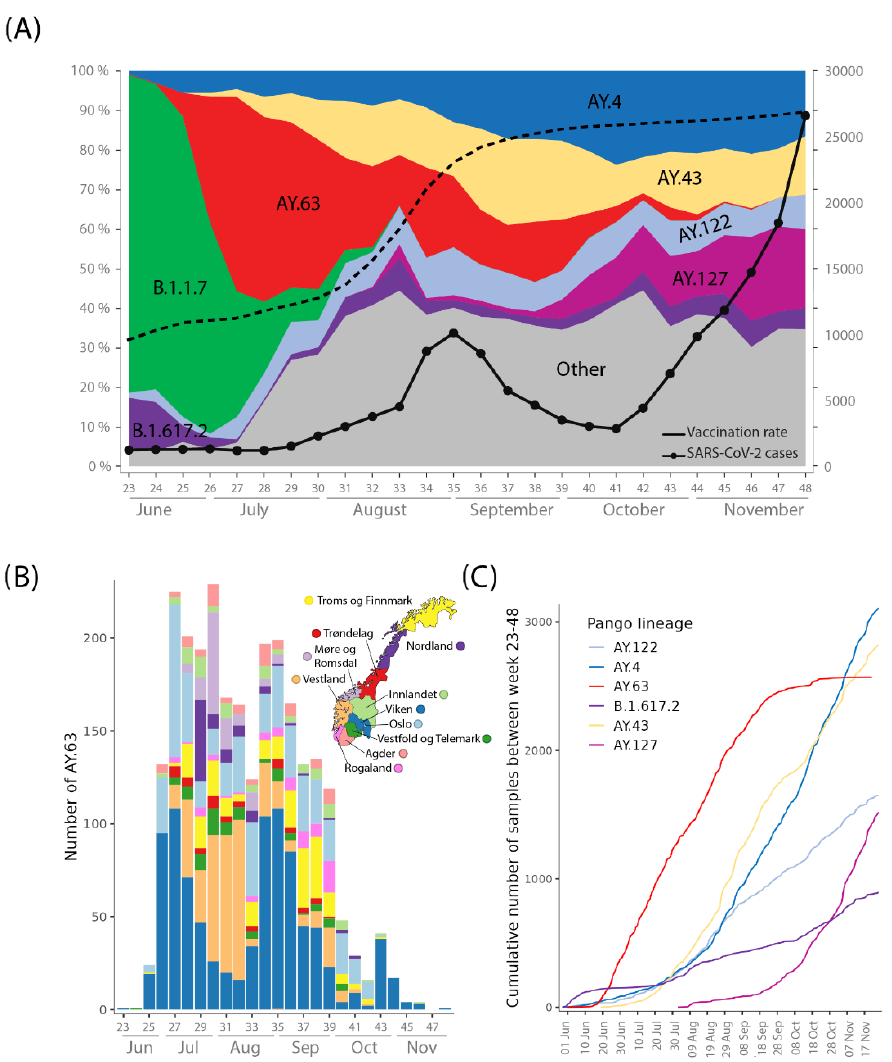
Figure 1. Spread of AY.63 in Norway, 2021. ( A ) Proportions of the B.1.1.7, AY.63, and the five most common Pango lineages circulating in Norway between weeks 23–48, 2021. “Other” lineages (colored grey) contain all other circulating lineages (including a few Omicron cases). The black dashed line shows the percent of people (<18 years) who had received two doses of vaccination against SARS-CoV-2. The black dotted line shows the numbers of positive SARS-CoV-2 cases in Norway (plotted on the secondary y -axis). Week numbers and months of 2021 are shown on the x -axis. ( B ) Number of sequenced samples of AY.63 colored by Norwegian county. The x -axis is the same as in figure ( A ). The map was adapted from Wikipedia.org (accessed on 10 October 2022). ( C ) Cumulative cases of sequenced samples of AY.63 and the five other most frequent Delta lineages in weeks 23 – 48.